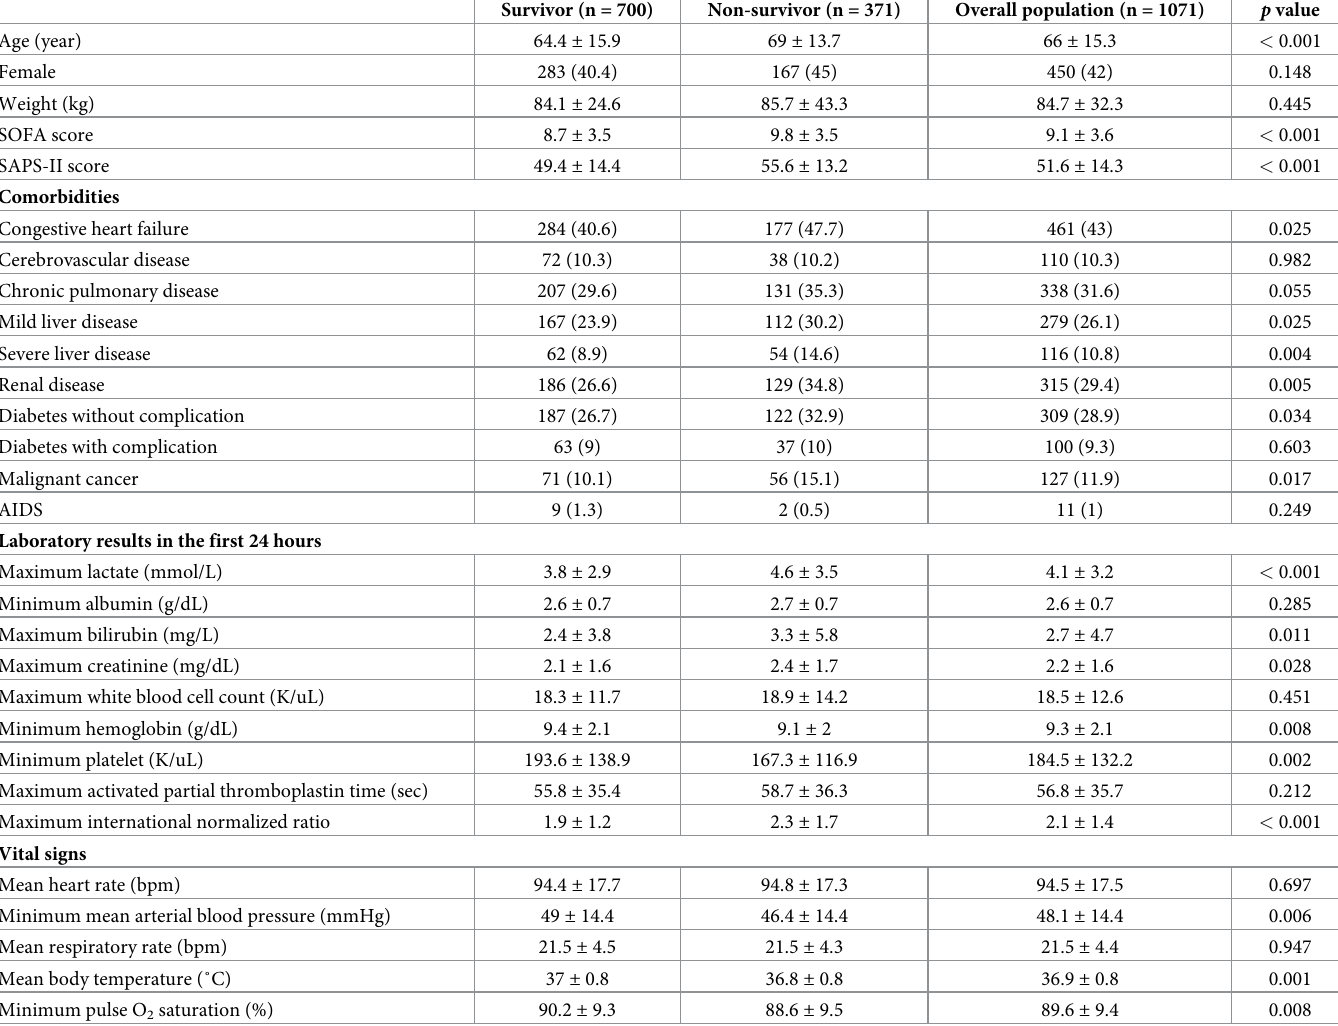
Table 1. Comparisons of the baseline clinical characteristics between survivors and non-survivors in the first 24